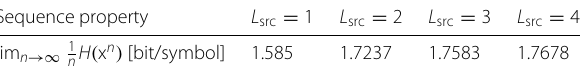
Table 1 Source entropy rates of reconstructible sequences Sequence property L src = 1